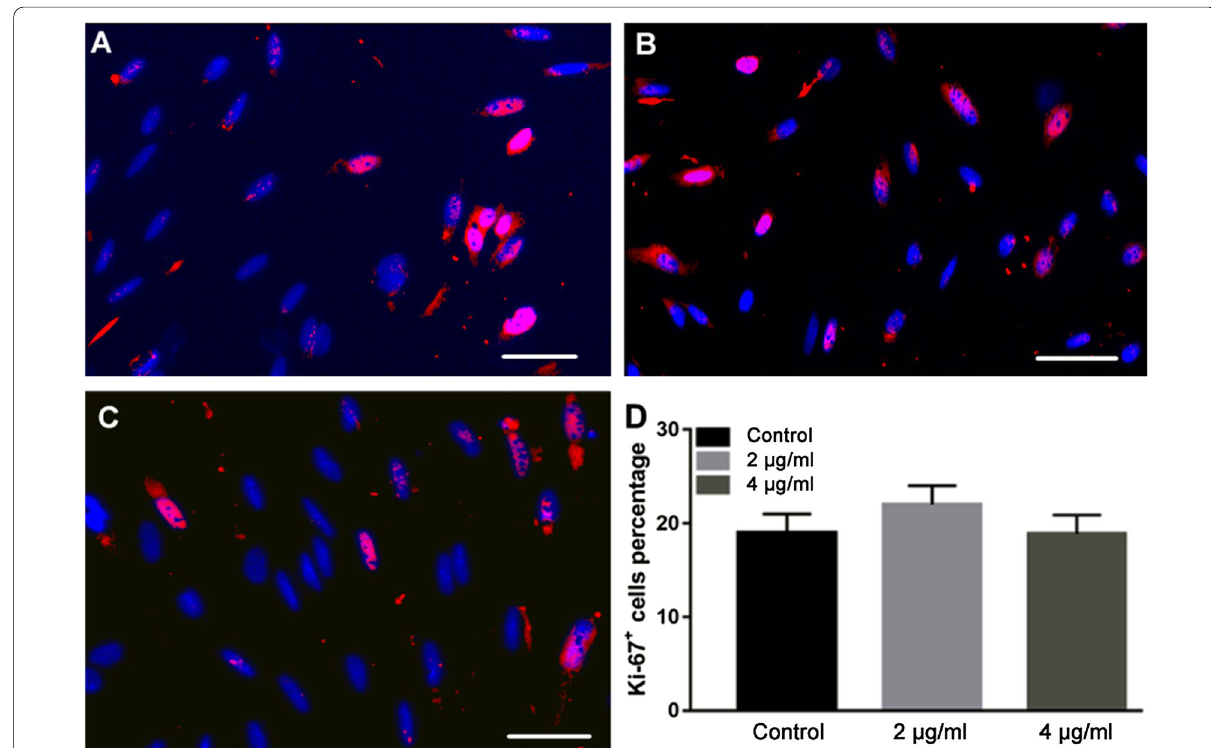
Fig. 4 The evaluation of cell proliferation of the BPs-treated group. EMSCs were treated with BPs (0, 2, and 4 μg/ml) for 24 h. Cell proliferation was measured by immunofluorescent staining with anti-Ki67 antibody (red) and DAPI (blue), and merged images were shown ( A – C ). Ki67-positive cells among 4 ′ ,6-diamidino-2-phenylindole (DAPI)-positive cells were counted in two high-power fields in each of three plates. Data are expressed as the mean SD ( D ±